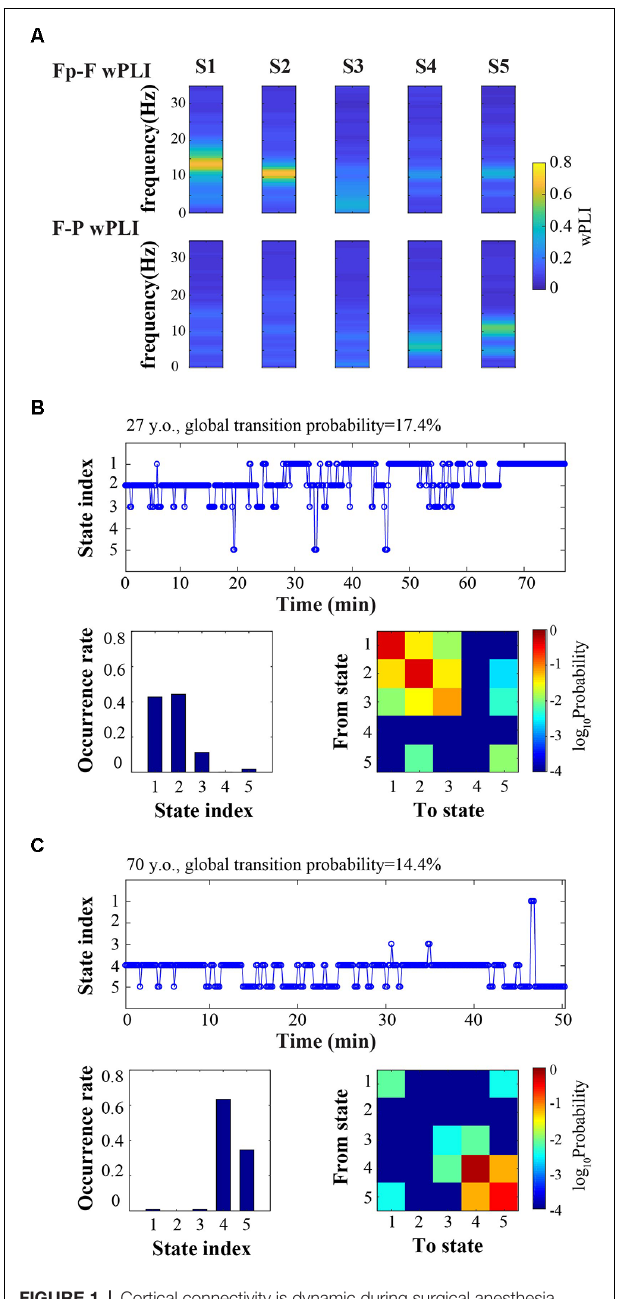
FIGURE 1 | Cortical connectivity is dynamic during surgical anesthesia. (A) Representative connectivity states (S1, S2, S3, S4, S5) characterized by distinct frequency-resolved patterns of prefrontal-frontal (Fp-F) and frontal-parietal (F-P) weighted phase lag index (wPLI). (B,C) Time courses of connectivity states (top), occurrence rate (bottom left), and state transition matrix (bottom right) for an example younger subject ( B , 27-year-old) and an example older subject ( C ,